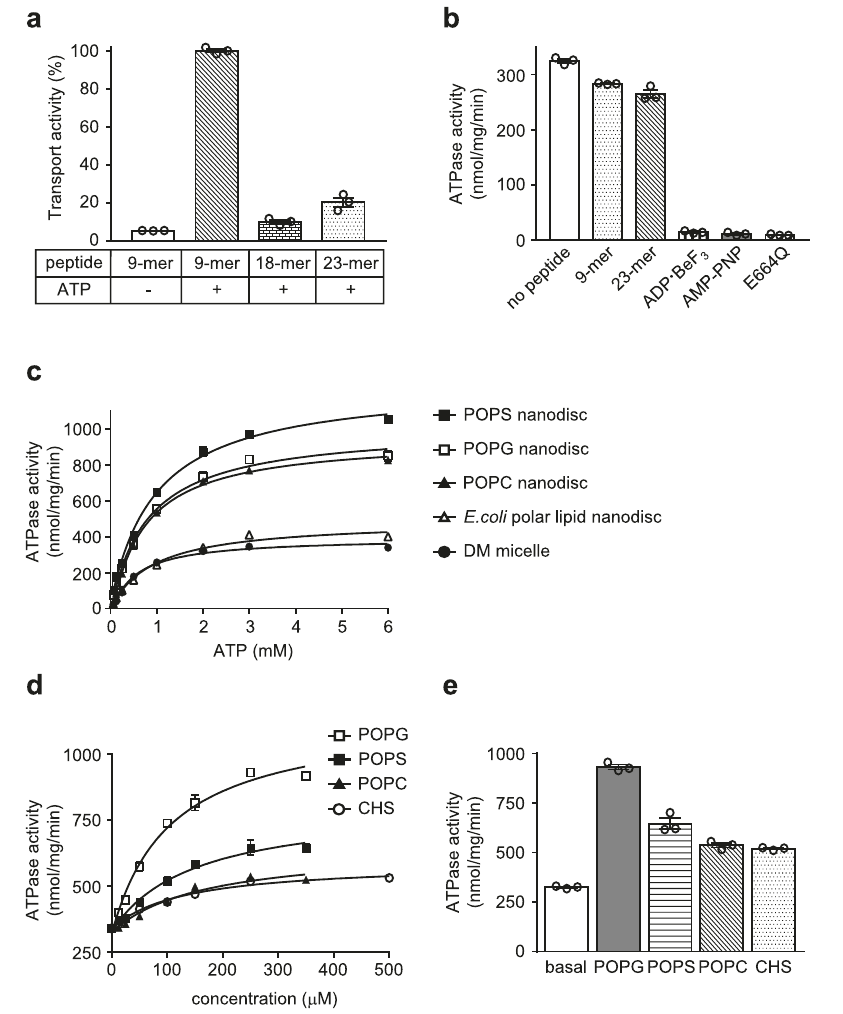
Fig. 1 | Functional characterization of mouse TAPL. a Peptide transport activity. Activity measured in the presence of 10 μ M 5-IAF-labeled 9-mer peptide and 3mM ATPwassetat100%.Thedatarepresentmeans±standarderrorofthemean(SEM) of triplicate measurements of three different batches of proteoliposome prepara- tions. Source data is provided as a source data fi le. b ATPase activities of DM- puri fi ed wild-type and the E664Q mutant in the presence of 250 μ M peptides or ATP analogs (2mM ADP·BeF 3 or 3mM AMP-PNP). Each point is the mean of three replicate experiments using the same preparation. Error bars represent SEM. Source data is provided as a source data fi le. c ATPase activities of Δ TMD0 in DM micellesorvariousnanodiscs.Dataareexpressedasmeans±SEMofthreeseparate experiments using the same preparation. Source data is provided as a source data fi le. d ATPaseactivitiesofDM-puri fi ed Δ